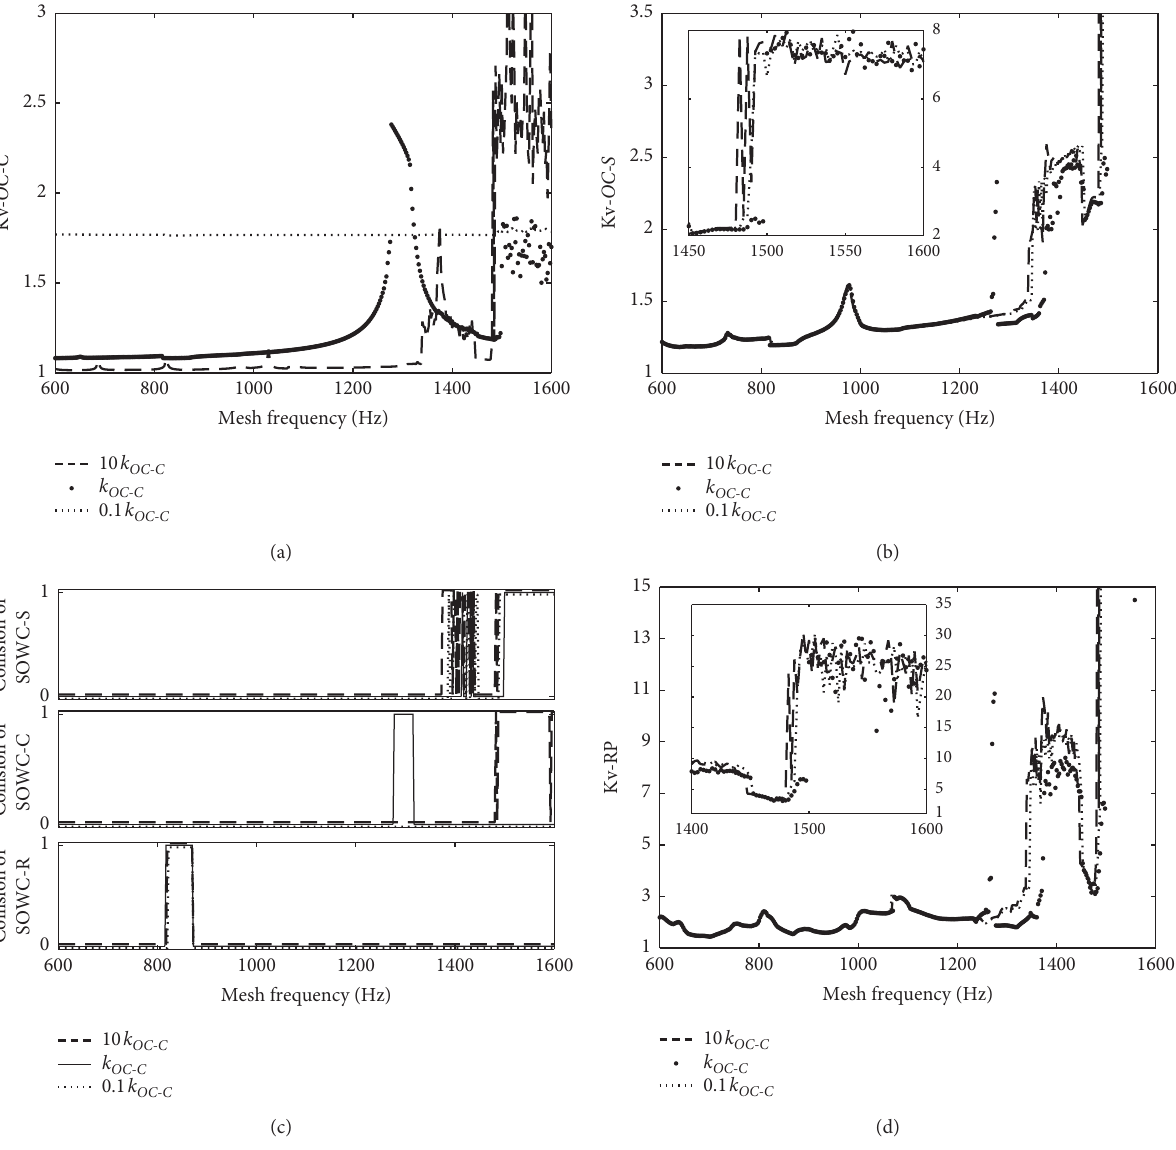
Figure 10: Nonlinear dynamics of the unit as stiffness of SOWC-C changed. (a) Load characteristics of SOWC-C. (b) Load characteristics of SOWC-S. (c) Collision of each SOWC. (d) Load characteristics of